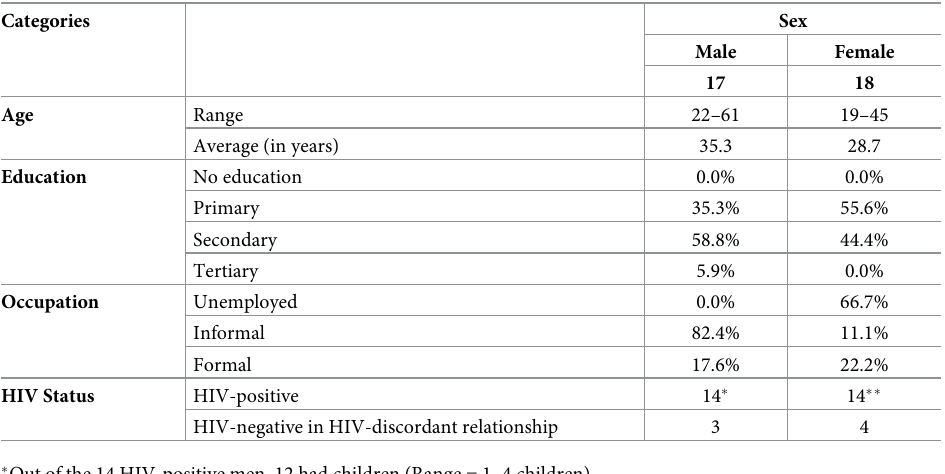
Table 1. Demographic characteristic of IDI